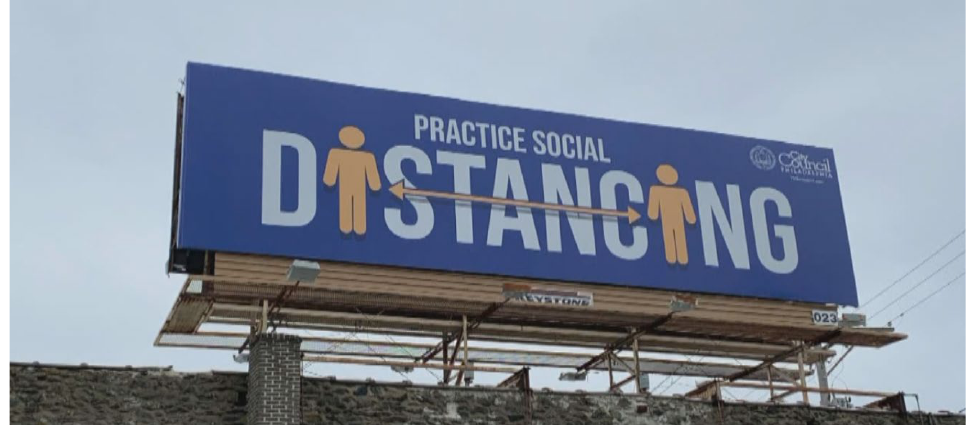
Figure 3 – Social advertising by City Council,